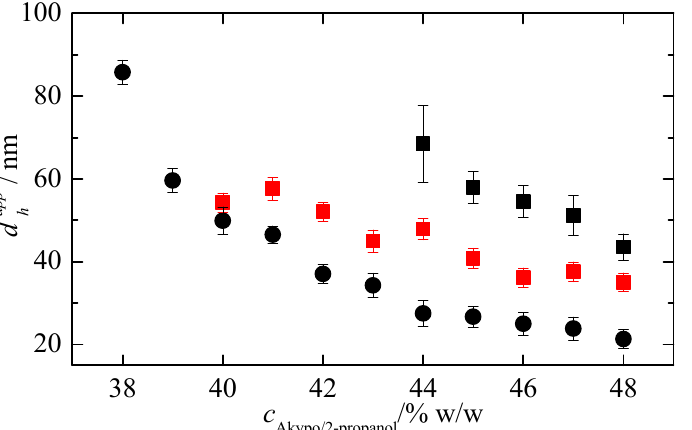
Figure 4. Dependence of the apparent hydrodynamic diameter on the concentration of emulsifiers (Akypo/2-propanol mixture, c Akypo/2-propanol ) for the studied O/W microemulsions obtained in this study: ( ■ ) O/W microemulsions with surfactant/co-surfactant mixture ratio 3/1 and oleic acid. ( ■ ) O/W microemulsions with surfactant/co-surfactant mixture ratio 3/1 and soybean oil. ( ● ) O/W microemulsions with surfactant/co-surfactant mixture ratio 1/2 and oleic acid. The oil content in all the dispersions was 3% w / w .